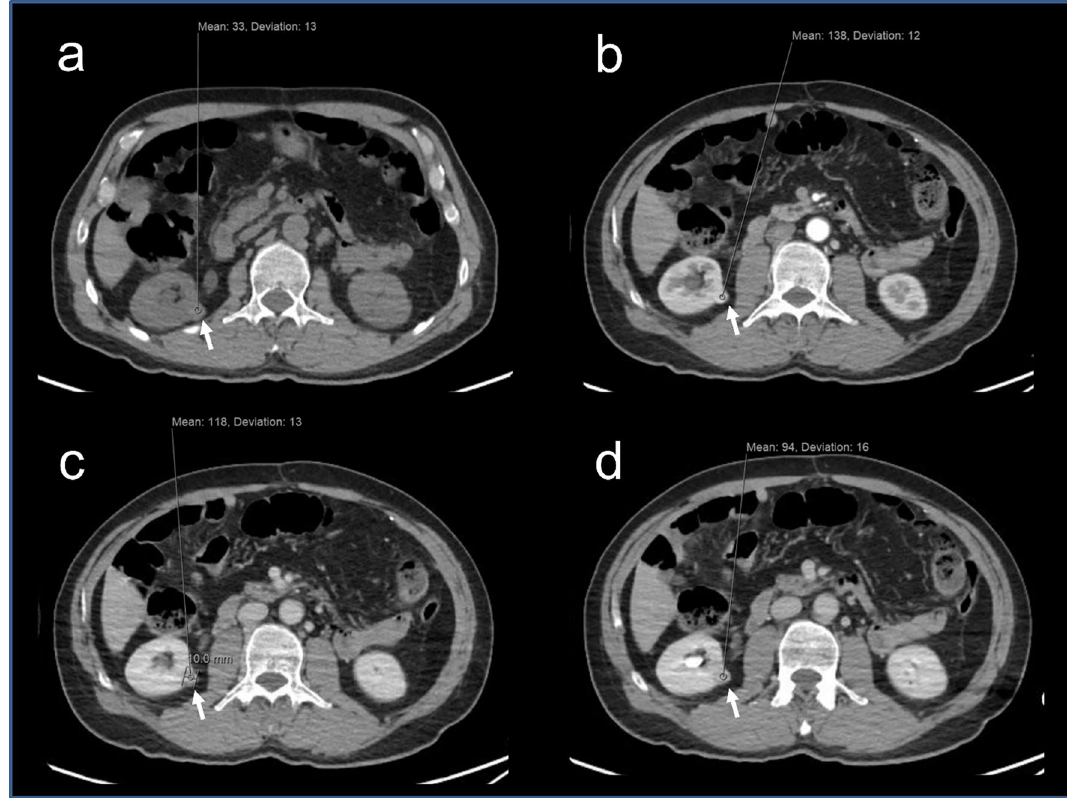
Figure 2. CT scan of the abdomen at follow up of the same patient after 2 years showing Hounsfield density measurement of the renal tumor consistent with right RCC (arrows). ( a ) CT without contrast, lesion density